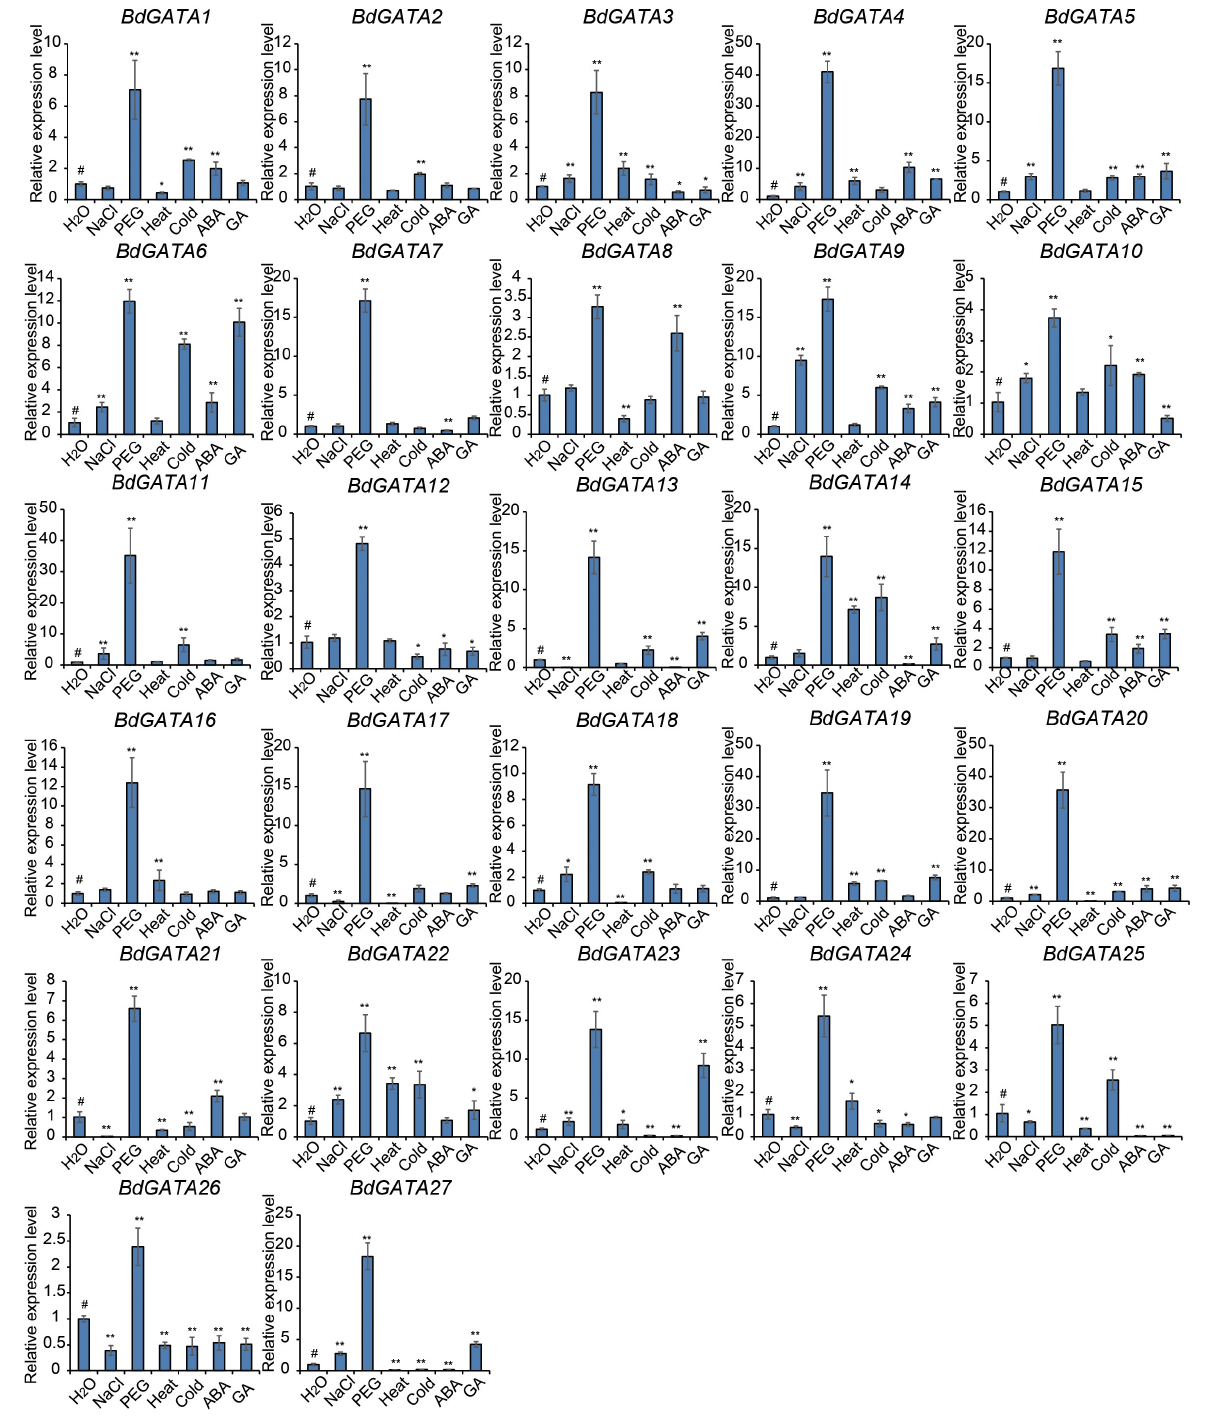
Frontiers in Plant Science |